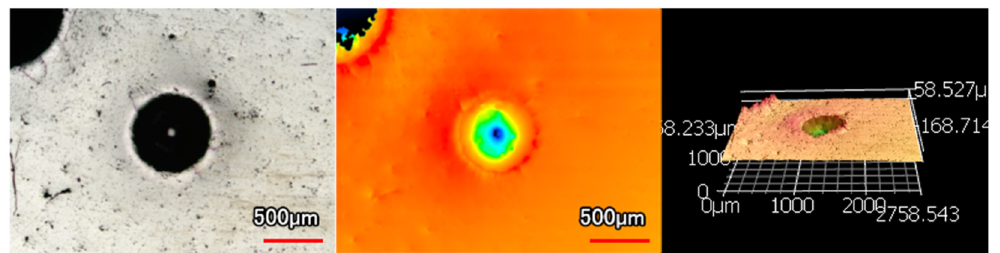
Figure 5. Rockwell Indentations on Ni-P Coating: ( a ) Radial and Hertzian Cracks, ( b ) Hertzian Cracks.